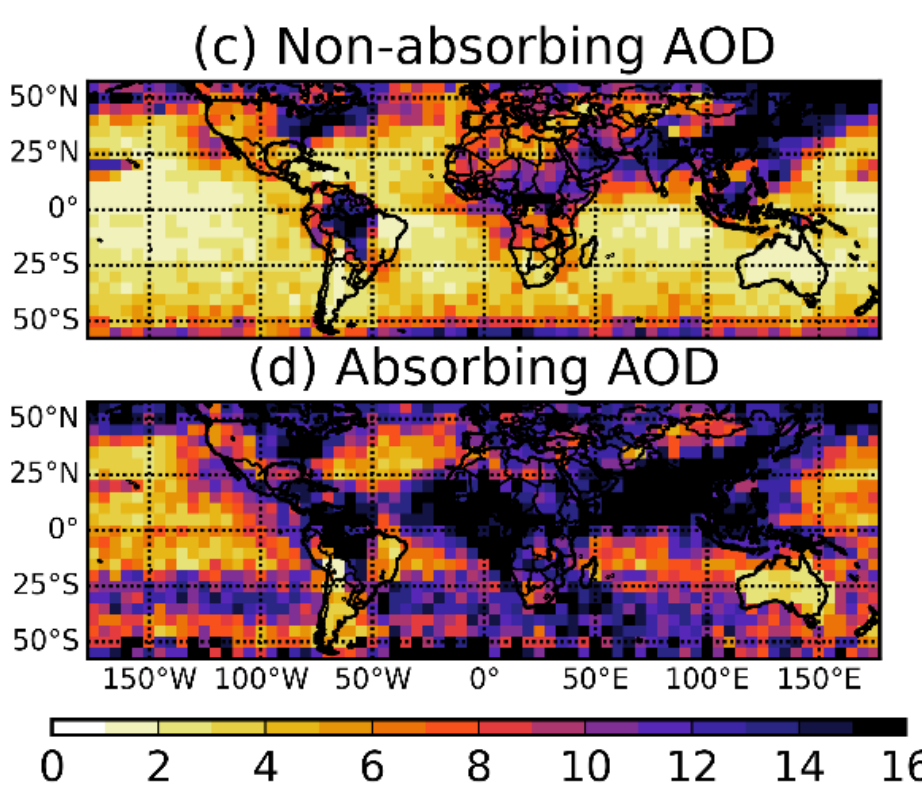
Figure A5. The minimum record lengths required to obtain stable seasonal climatology of ( a ) total, ( b ) nonspherical, ( c ) nonabsorbing, and ( d ) absorbing aerosol optical depths in Summer (June-July-August) within the predefined accuracy levels ( ± 0.01 AOD for ( a ), ± 0.004 for ( b ), and ± 0.005 for ( c ) and ( d )).